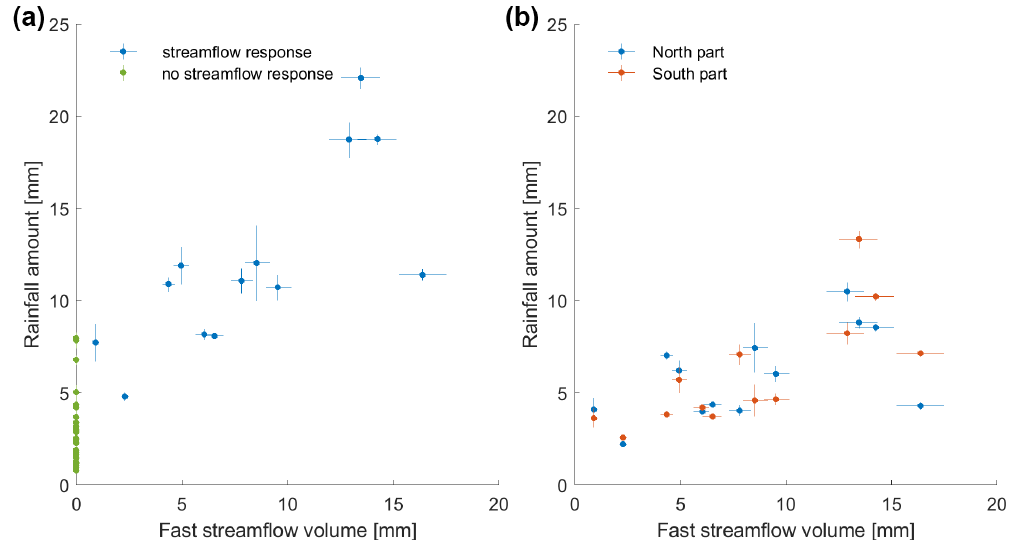
Figure 7. Scatterplots of (a) total rainfall amounts versus fast streamflow (highlighting the threshold for streamflow response) and (b) of rainfall amounts in the northern and the southern part against fast streamflow (for the separation line, see Fig. 1a). The bars show the standard deviation of estimated rainfall (Sect. 3.2) and of streamflow (Sect. 2). The events of 24 July ( P ALL = 8 . 0mm; Q FAST = 30 . 4mm) and of 6 August ( P ALL = 43 . 5mm; Q not recorded) are out of the axes in (a) and in (b)